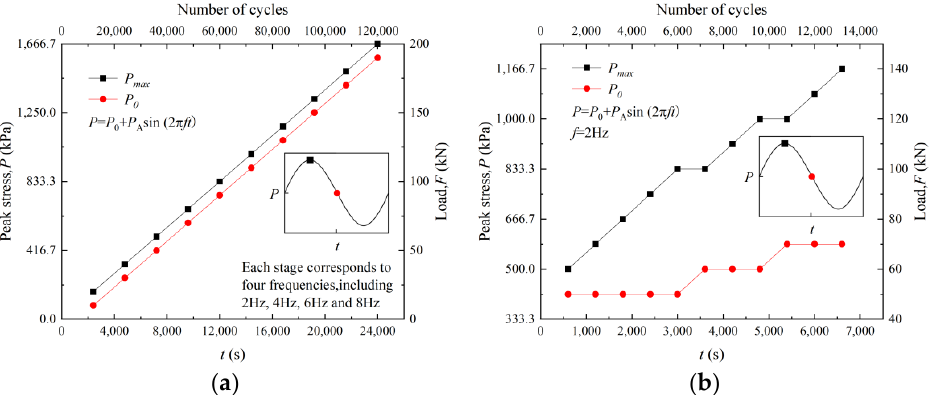
Figure 6. Dynamic load loading method. ( a ) Equal amplitude loading. ( b ) Equal frequency loading.